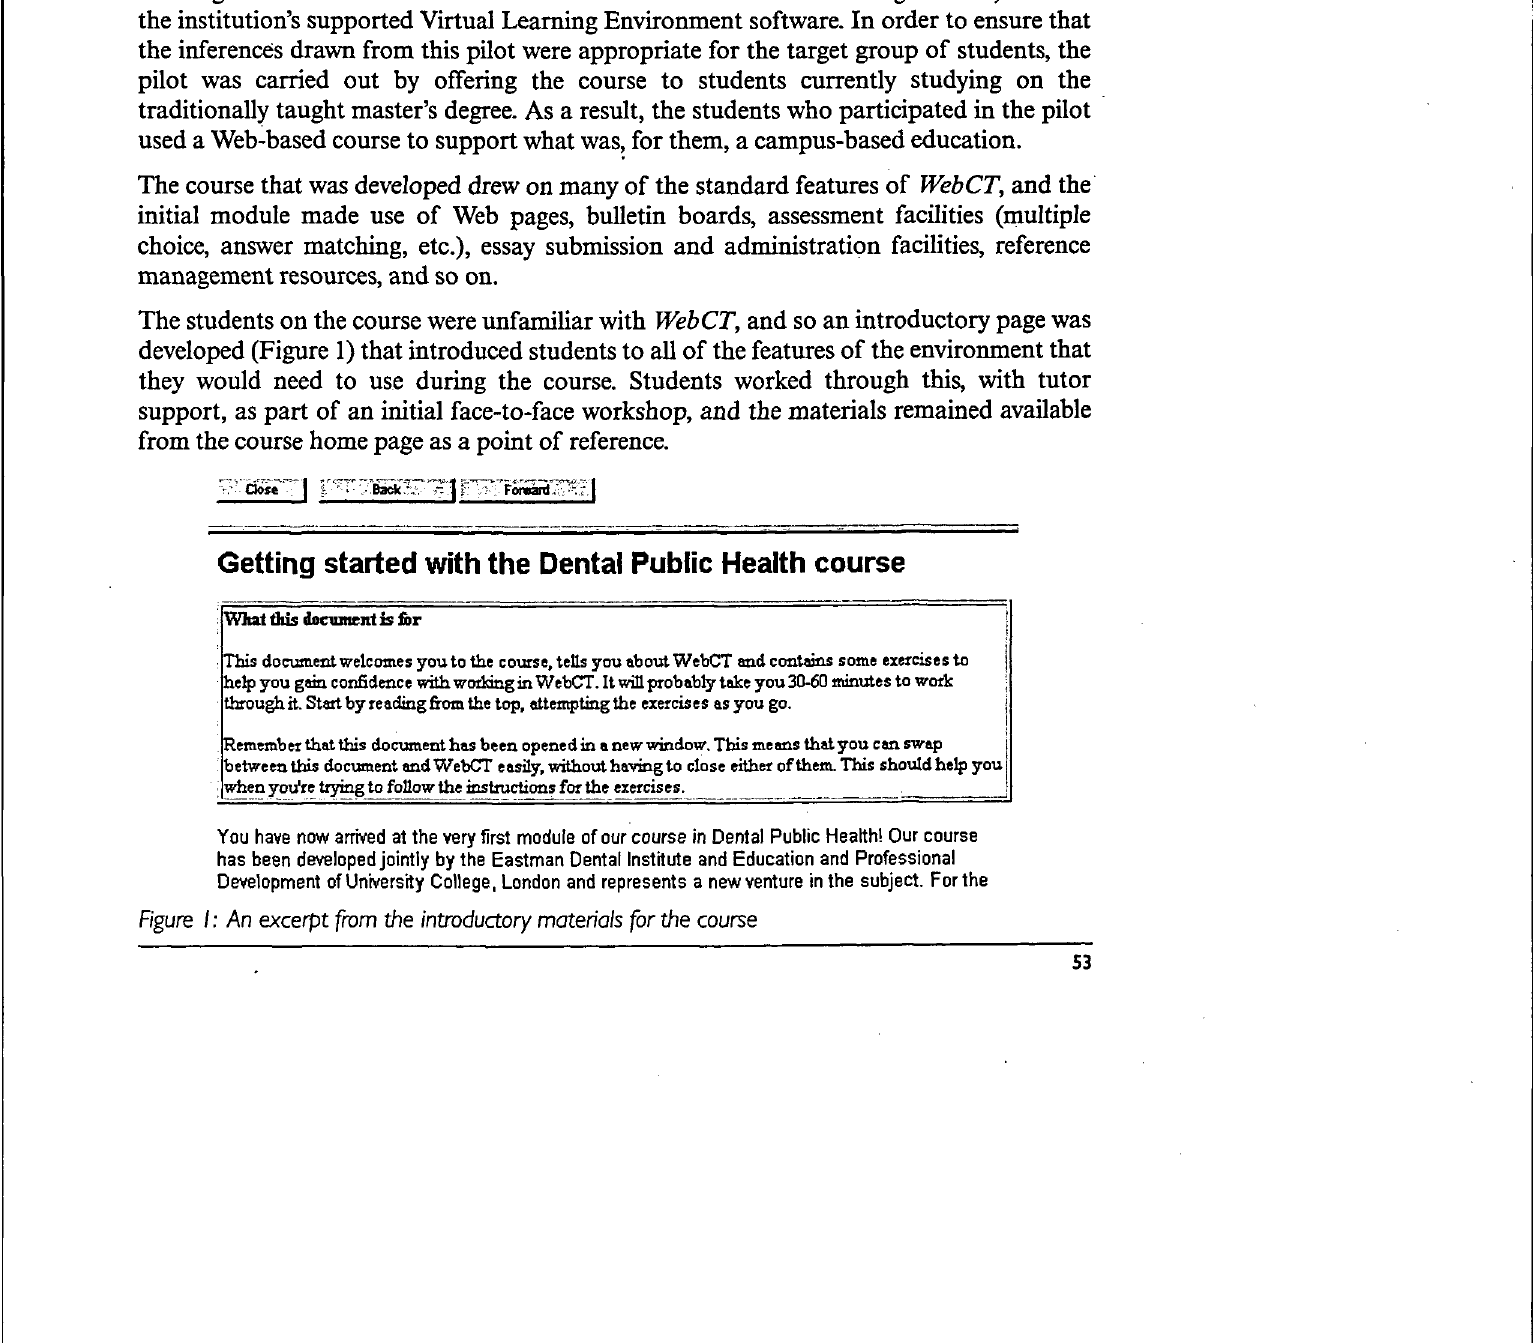
Figure I: An excerpt from the introductory materials for the